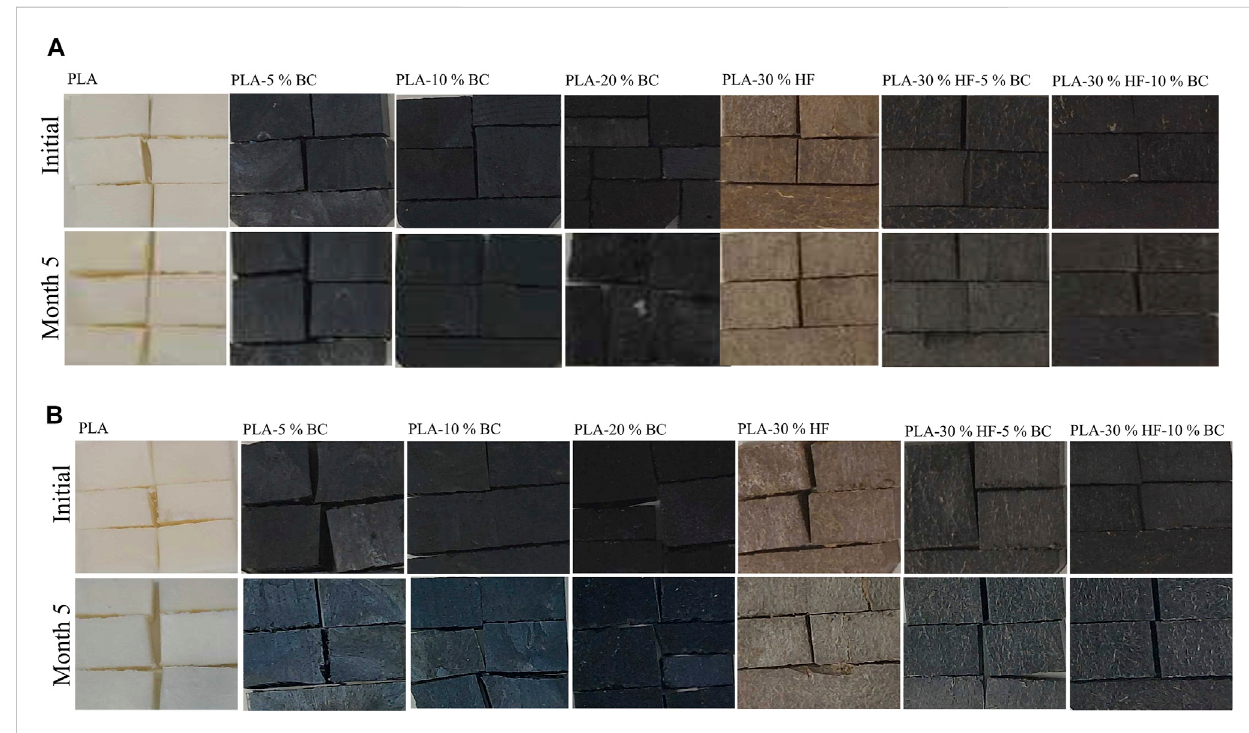
FIGURE 2 Photographs of the specimens before and after 5 months of incubation with (A) white rot and (B) brown